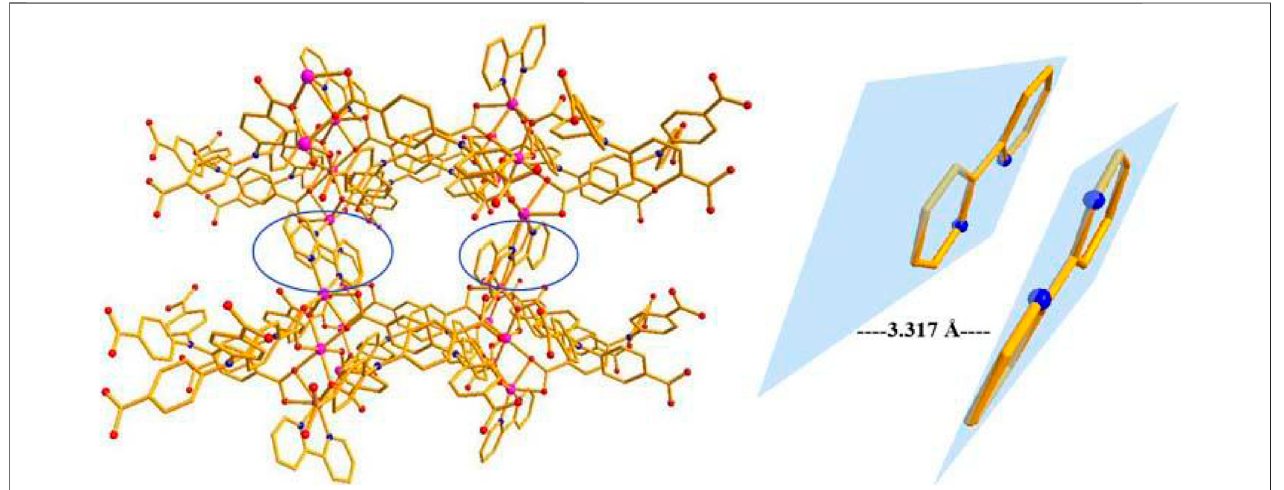
FIGURE 3 | The structure of compound 1 and interactions of π – π stacking (C: Gray, O: Red, N: Blue, Co:Purple).